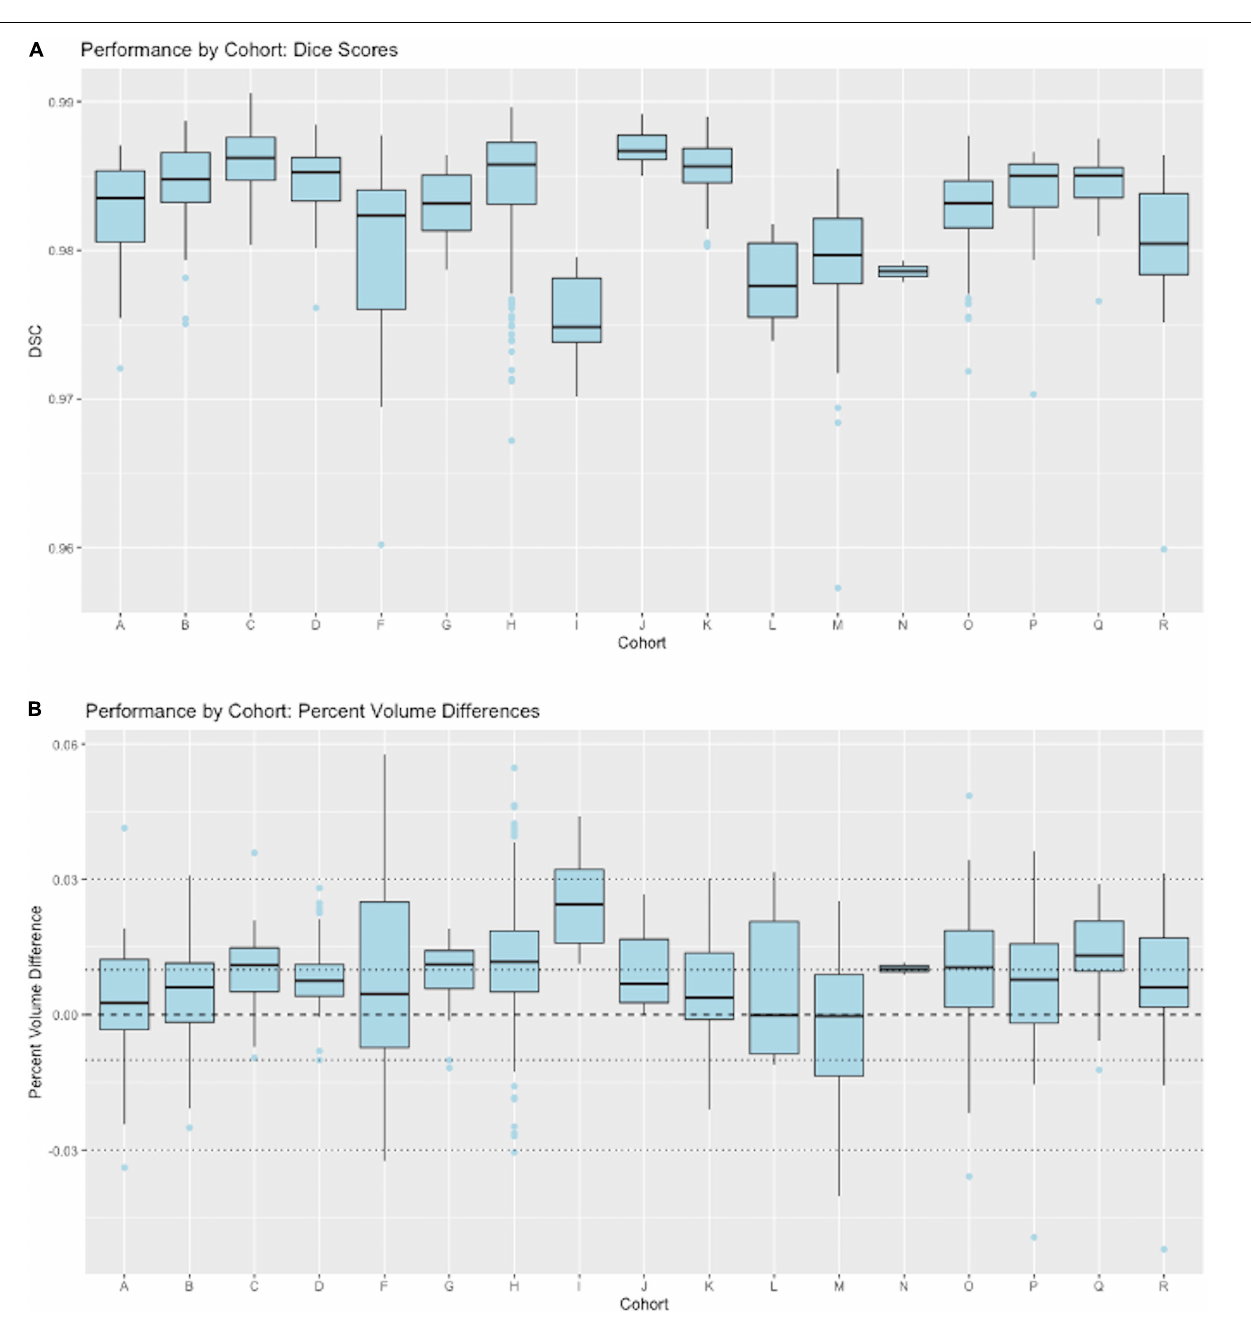
FIGURE 8 | CNN performance by imaging cohort. These show matching scores for the best performing model in Figure 4 (5-stage, 11 cohort). (A) Box plots of DSC distributions. (B) Same for percentage volume mismatches (predicted volume – GT volume)/GT volume.